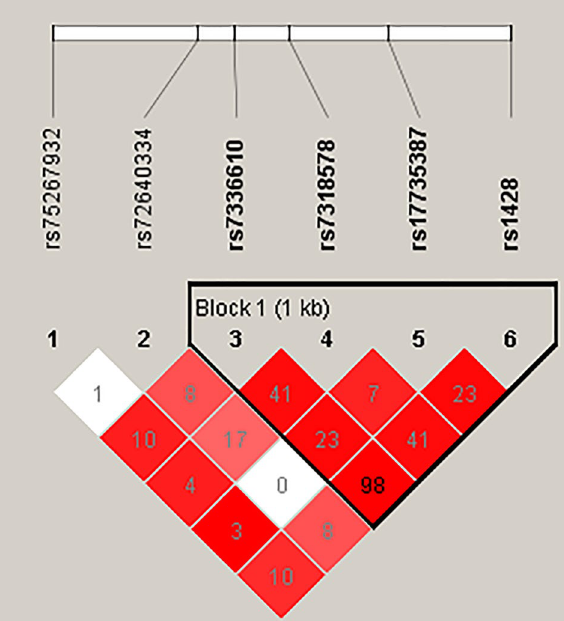
Figure 2. LD plots of six SNPs in the MIR17HG gene. Haploview-4.2 software: https:// www. broad insti tute. org/ haplo view/ downl oads# JAR. The squares in the graph represent the strength of linkage disequilibrium (r2) between every two SNPs. The darker the color, the greater the r2 value. The inverted black triangles represent haplotype blocks defined by the confidence interval method. Agena MassARRAY Assay Design 3.0 software: https:// seqpw s1. agena bio. com/ Assay Desig nerSu ite. html# design: new= Genot yping. Agena Typer 4.0 software: (Agena, San Diego, CA, USA) https:// seqpw s1. agena bio. com/ Assay Desig nerSu ite. html# design: new= Genot yping. The Agena Typer 4.0 software for genotyping was purchased from the MassARRAY chip company (Agena, San Diego, CA, USA).